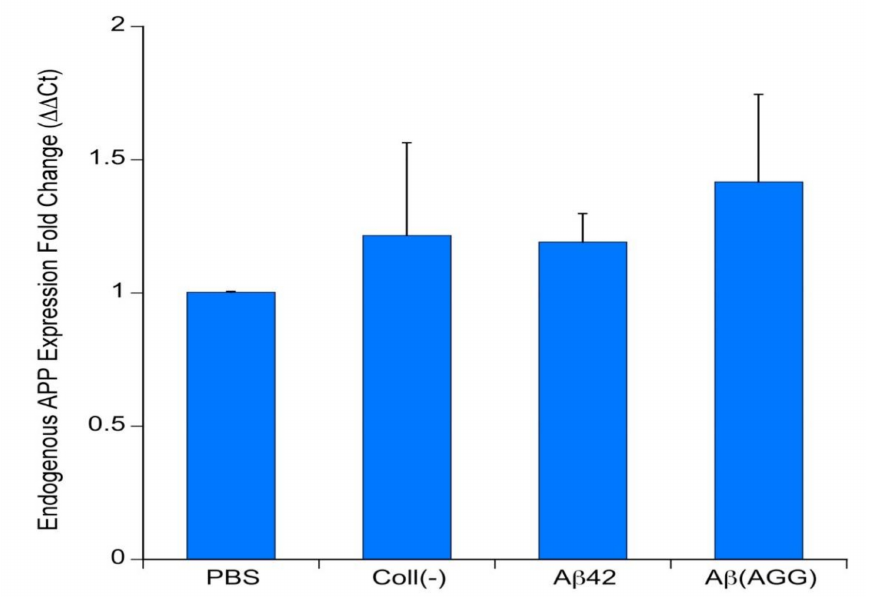
Figure 8. qRT-pPCR of endogenous amyloid precursor protein (APP) . Co-slices of wildtype mice were prepared and loaded with phosphate buffer saline (PBS) only, an empty collagen hydrogel (Coll(-)), a collagen hydrogel loaded with human beta-amyloid-42 (A β 42) or an aggregated beta-amyloid-42 (A β (AGG)). After eight weeks in incubation, slices were taken, RNA isolated and a qRT-PCR was done for endogenous mouse app gene and compared to the house keeping gene gapdh . Note that the treatment did not affect endogenous APP expression as evaluated by one-way ANOVA and Fisher LSD post hoc